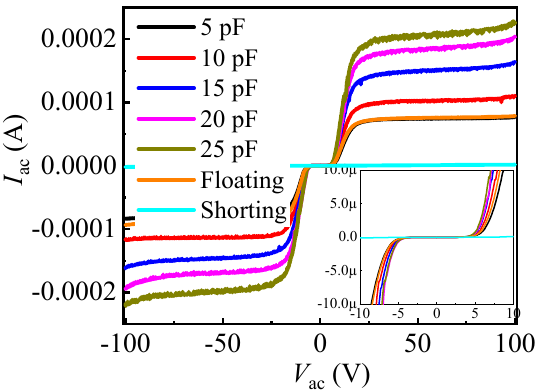
Figure 4. The static bidirectional leakage current characteristics of the proposed AlGaN/GaN B-ESD-PD with different C GA ( C GC ) values, accompanied by that of the gate-floating and GS-shorting bidirectional GaN diodes.